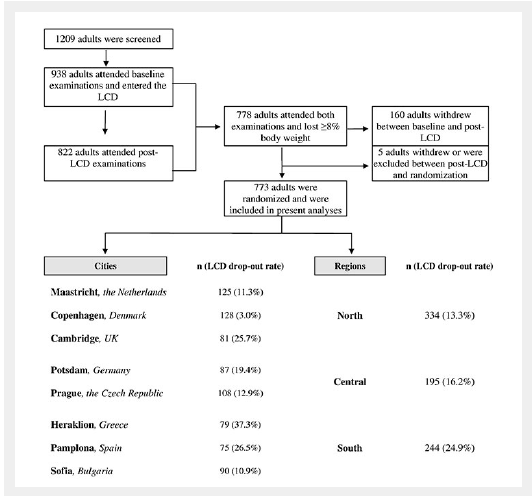
Figure 1 Flow diagram showing progress of the DiOGenes participants from screening to post-LCD, 2006–2007.